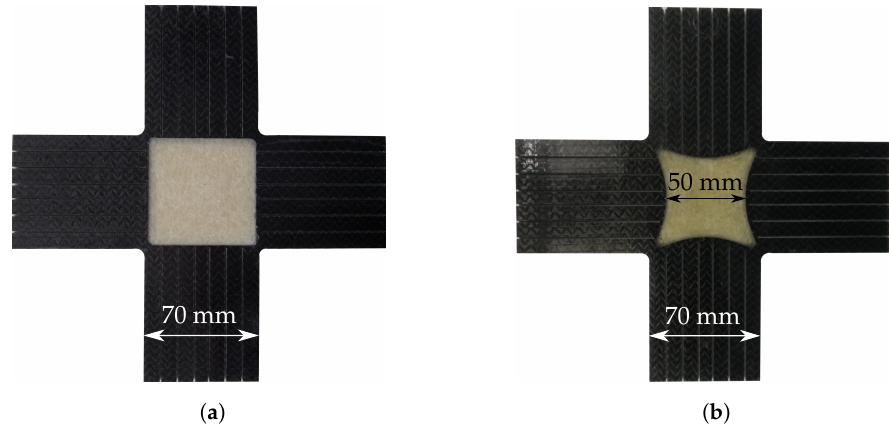
Figure 11. Images of specimens with continuous fiber reinforced arms, thickness of the area of interest: 1.7 mm. ( a ) Geometry 1; ( b ) Geometry